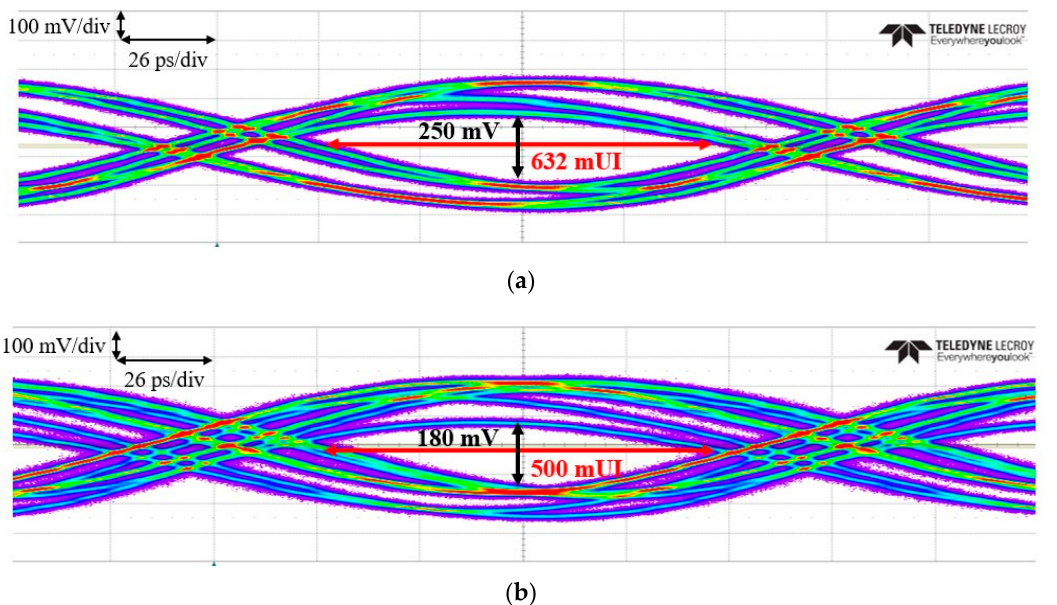
Figure 14. Eye diagrams of the PLL synchronized by injection for an ( a ) ‘0011’ sequence and ( b ) ‘00001111’ sequence.